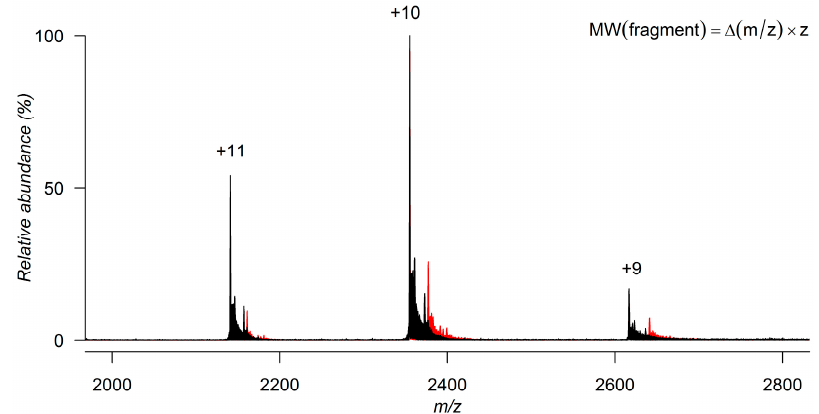
Figure 3. Superimposition of the ESI-MS spectra of Pv GK acquired under native conditions (10 mM ammonium acetate solution) before (black) and after incubation with a weakly binding fragment molecule (red). The molecular weight of the binding fragment can be determined by multiplying the difference between the protein-fragment complex peak and free protein peak ( Δ m / z ) by the corresponding charge state ( z ).